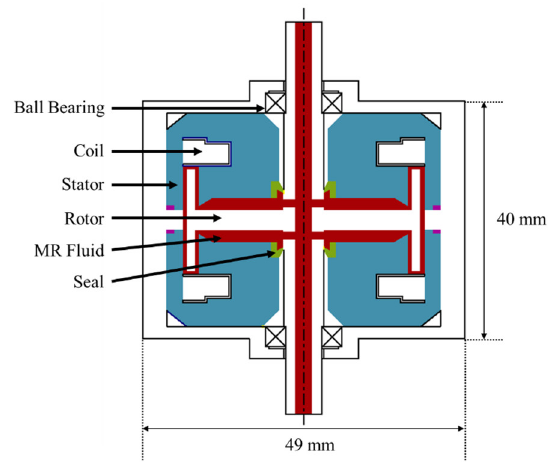
Figure 10. T-shaped MR brake for portable wrist rehabilitation device [88].